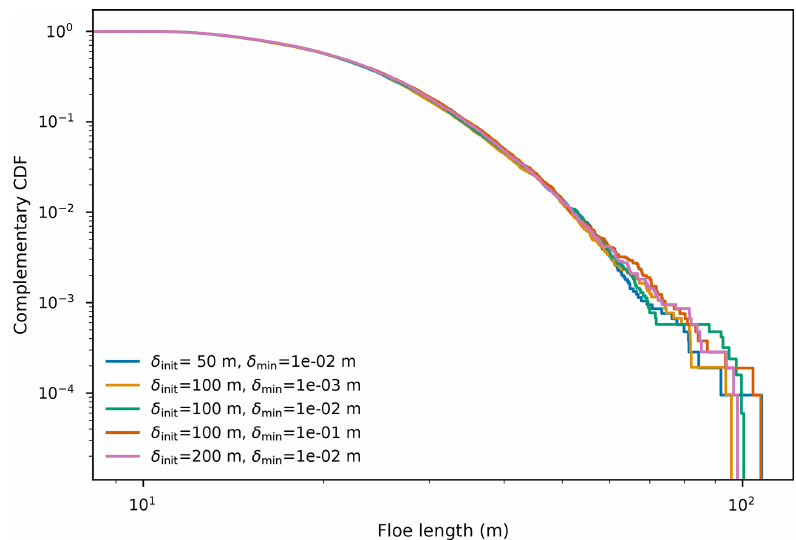
Figure A2. Complementary CDFs of floe lengths, averaged over 50 model realisations, with varied positioning parameters and model parameters mentioned in the text.